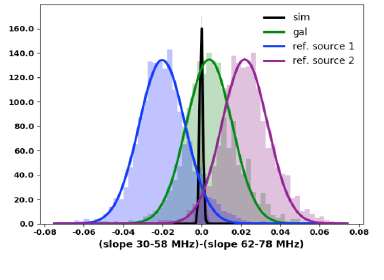
Figure 1. LOFAR signal chain, following sky power, P sk y to recorded power, P M . Gains, losses, and electronic noise additions are shown.